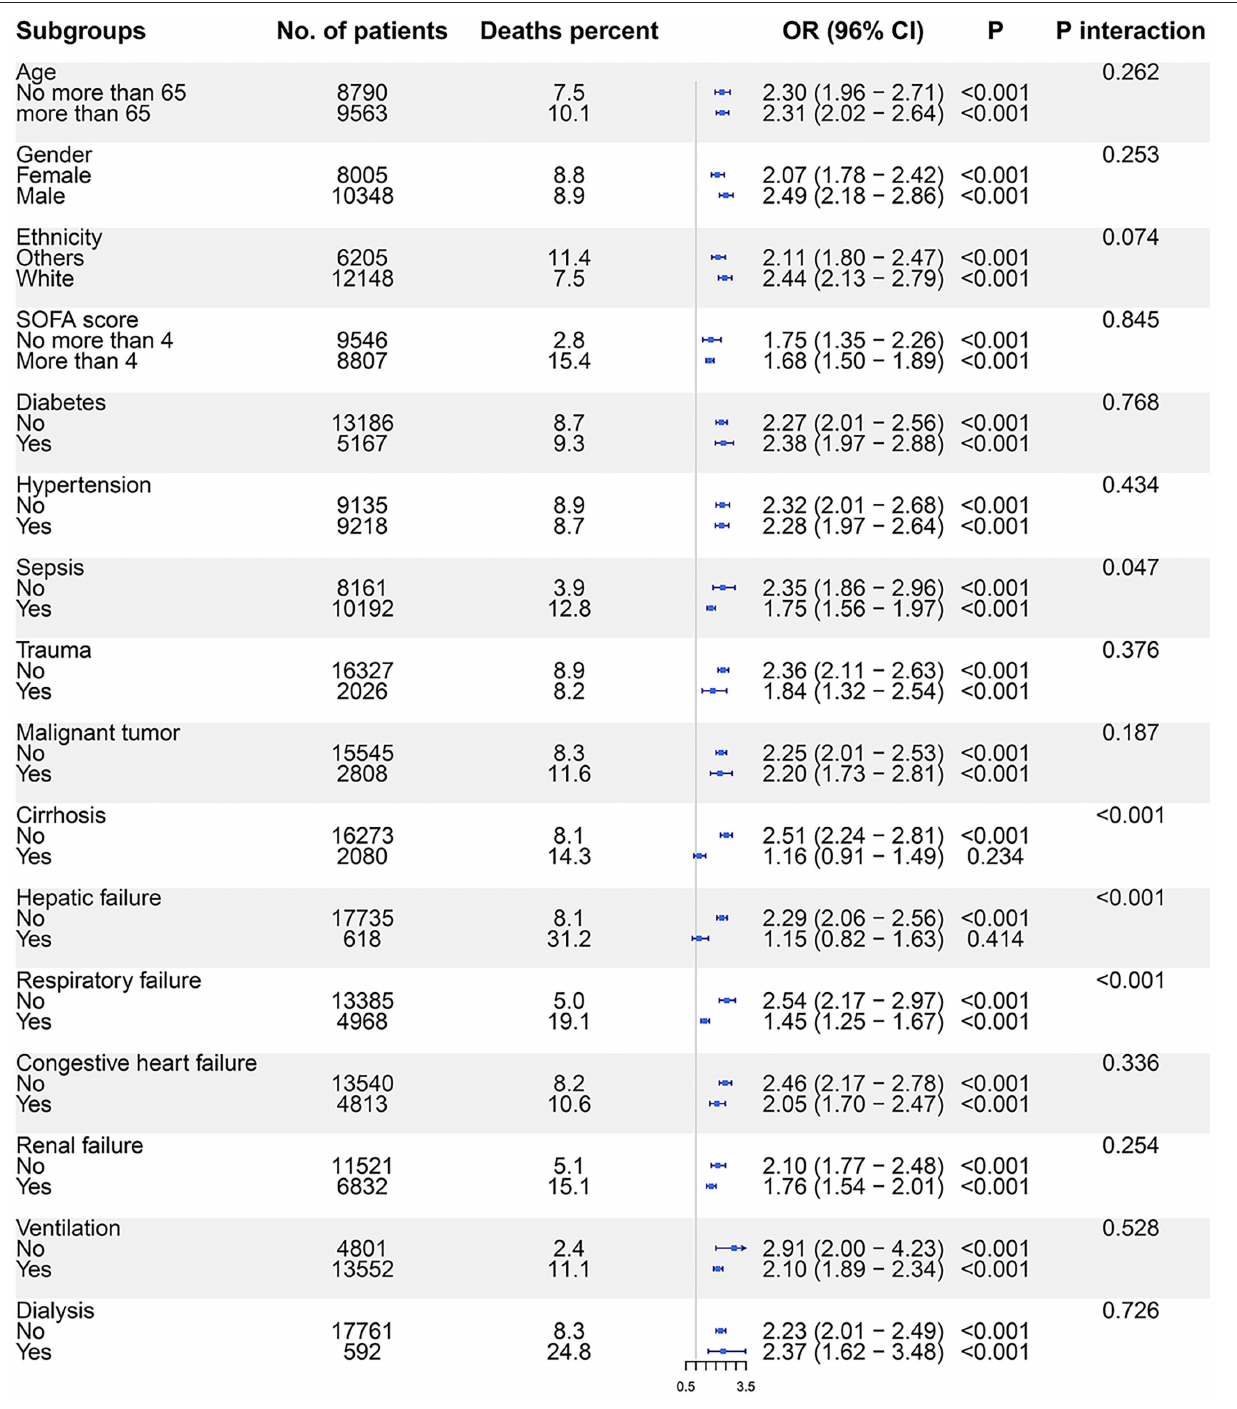
FIGURE 3 | The association between SAL and ICU mortality risks in subgroups. Logistic regression models were used to evaluate the ICU mortality risks for patients with SAL < 30 g/l compared with those with SAL ≥ 30 g/l. SAL, serum albumin level; ICU, intensive care unit; OR, odds ratio; CI, confidence interval.